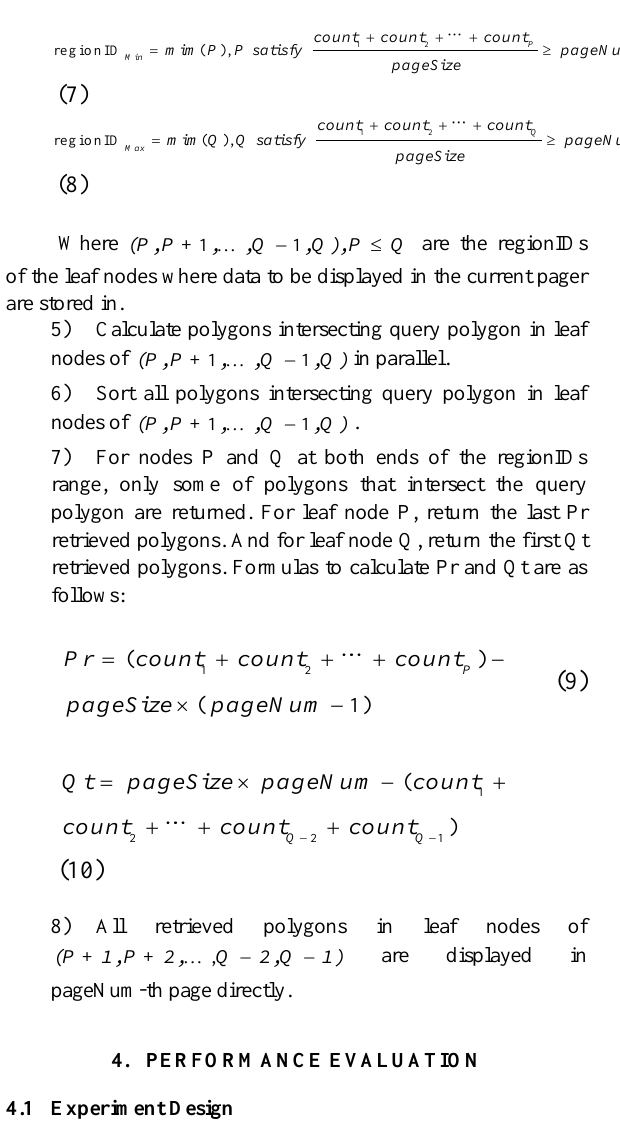
retrieved is huge, the general method to display the results is via paging. Thus, after the total number of intersected polygons and the regionIDs of leaf nodes containing intersected polygons are calculated, the Paging Query process is performed.